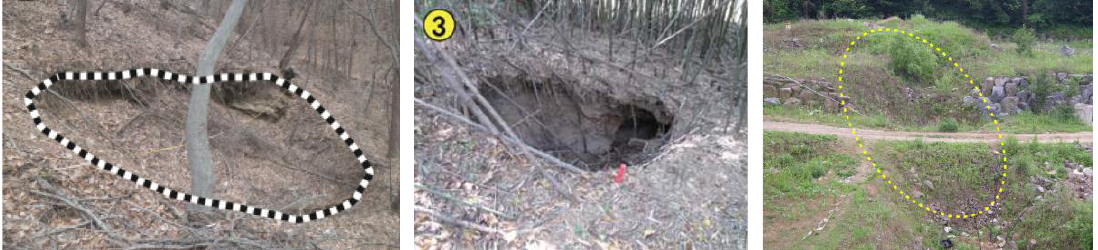
Figure 1. Typical examples of subsidence in this study .